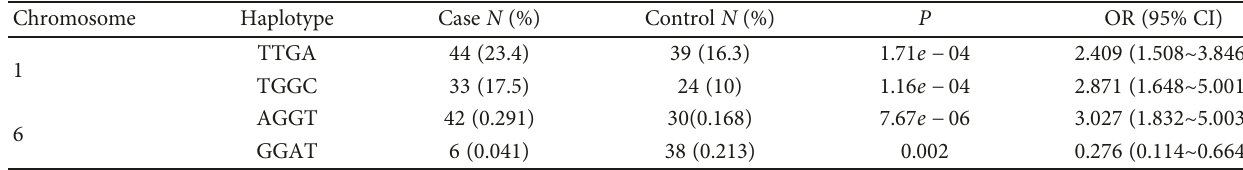
Table 4: Haplotypes of genotyped SNPs on chromosomes 1 and